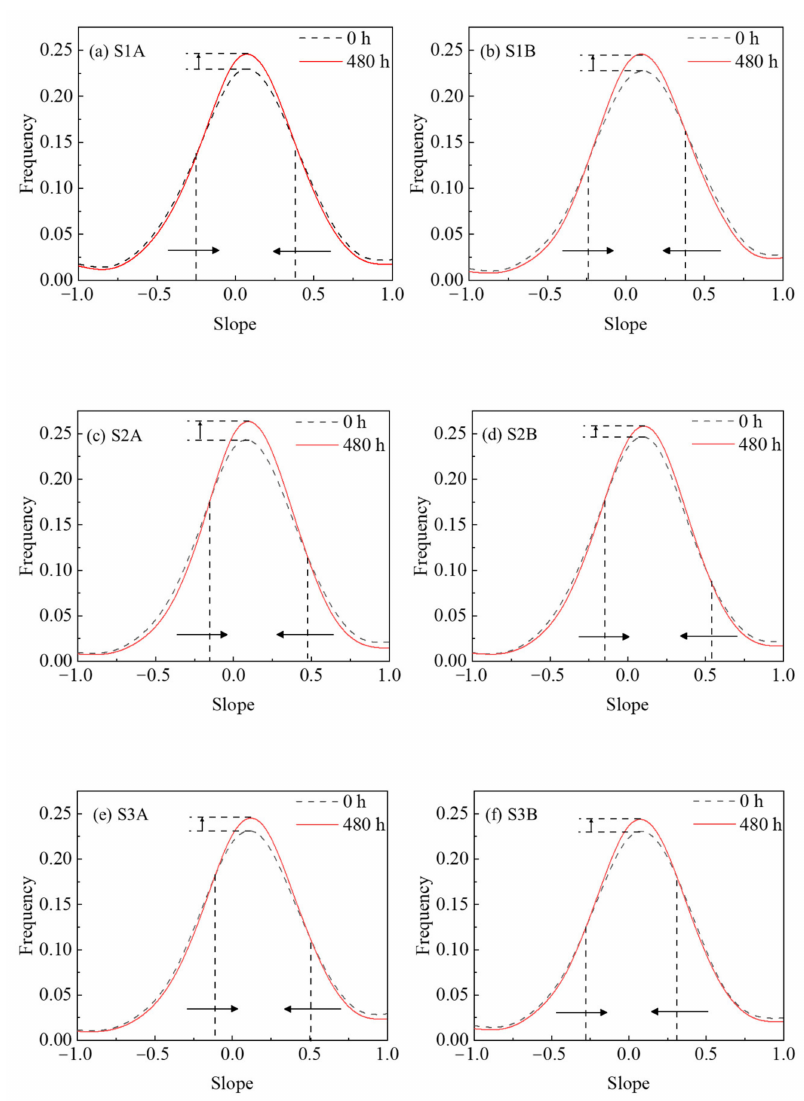
Figure 12. Temporal evolutions in slope distribution